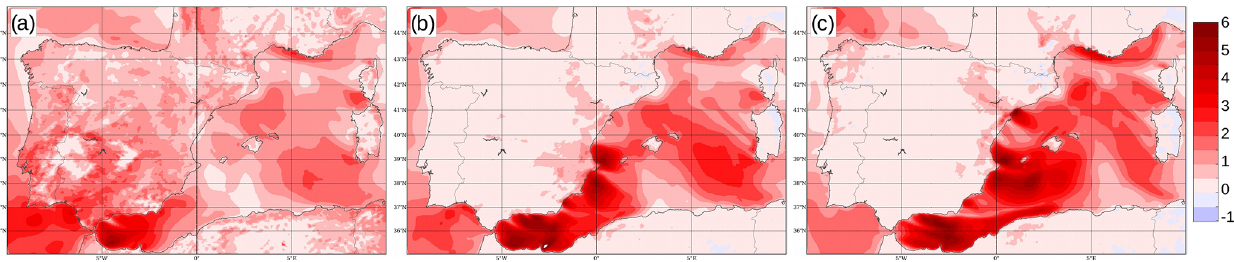
Figure 4. 6h cumulative surface evaporation (kgm − 2 ) from successive ARPEGE forecasts: (a) at 18:00UTC on 14 October (forecast basis: 14 October 12:00UTC), (b) at 00:00UTC on 15 October (forecast basis: 14 October 18:00UTC), and (c) at 06:00UTC on 15 October (forecast basis: 15 October 00:00UTC).